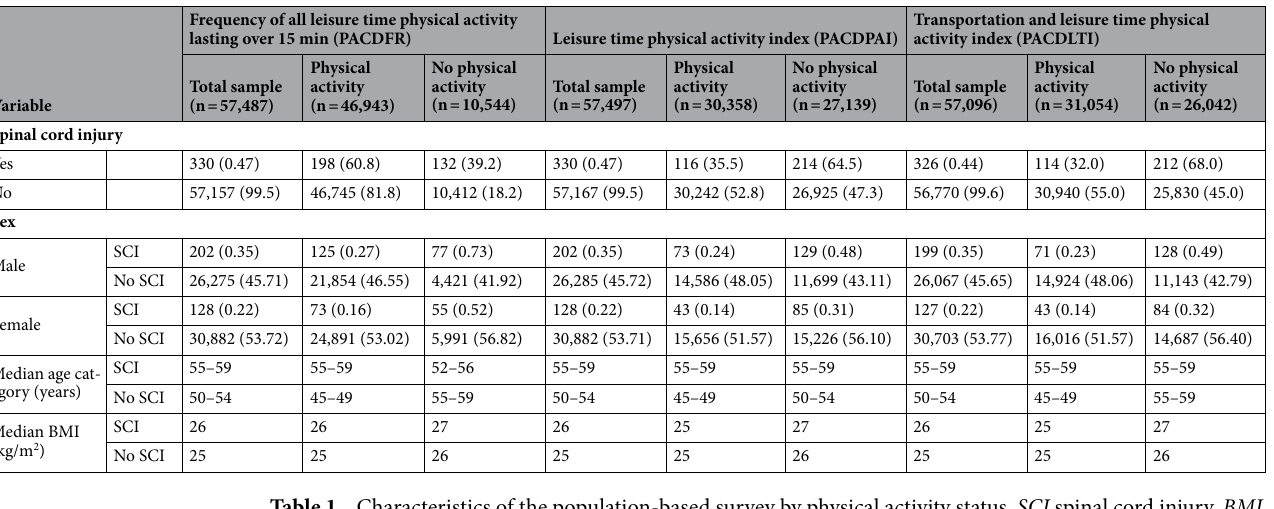
Table 1. Characteristics of the population-based survey by physical activity status. SCI spinal cord injury, BMI body mass